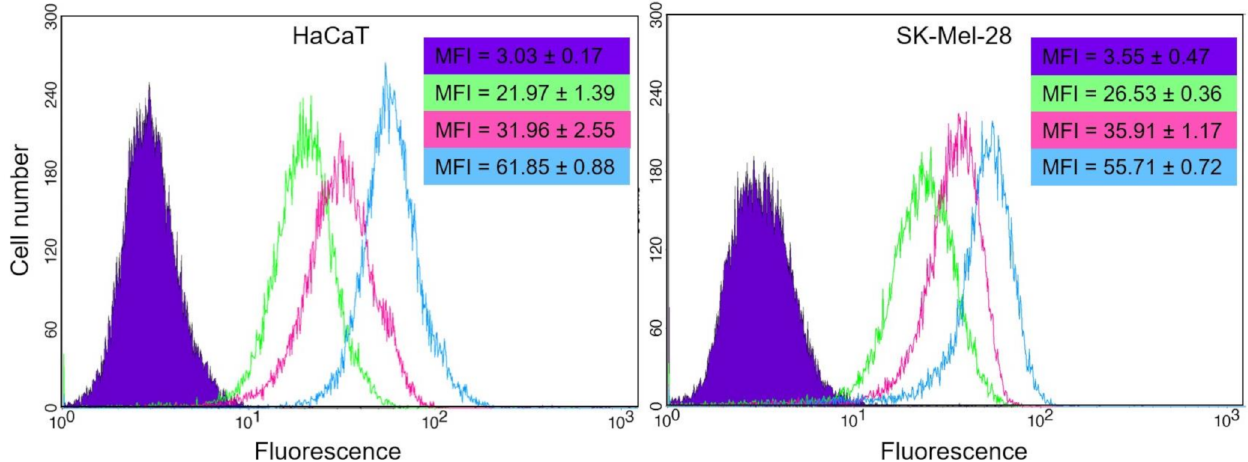
Figure 7. Histograms for ( HaCaT ) and ( SK-Mel-28 ) were obtained by flow cytometry after 1 (green), 2 (pink), and 4 (light blue) hours of incubation with F-UDL-Vis at 37 ◦ C. The untreated control is shown in violet. The presented histograms correspond to one of the replicates, and the mean fluorescence intensity (MIF) ± SD values obtained are denoted following the same color code. MFI is shown as mean ± SD ( n =